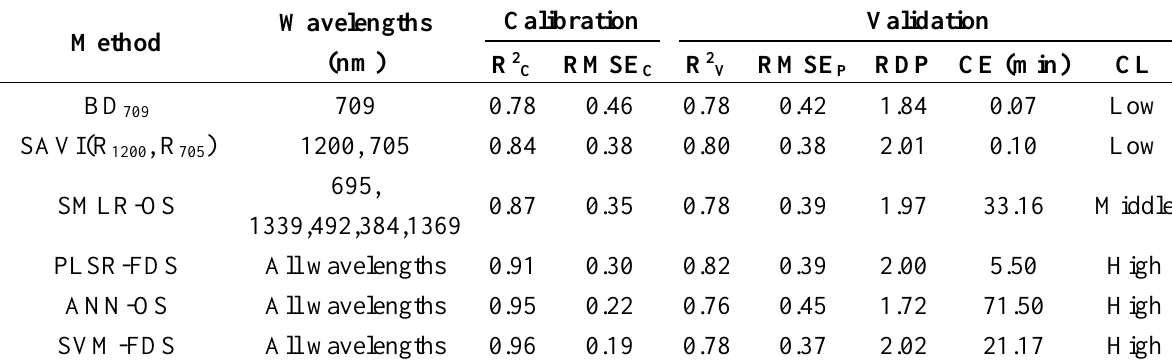
Table 9. The robustness evaluation of the wheat LNC models based on the six considered